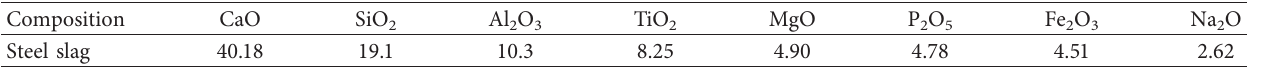
Table 1: Composition of steel slag.